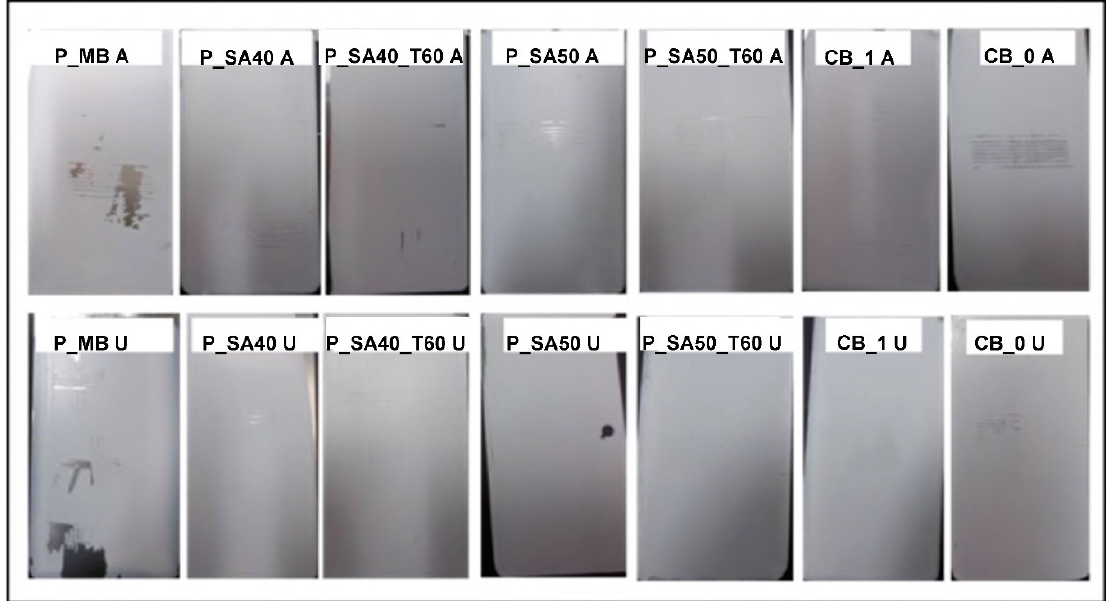
Figure 1. Results of adhesion test of the formulated paints onto steel substrates.